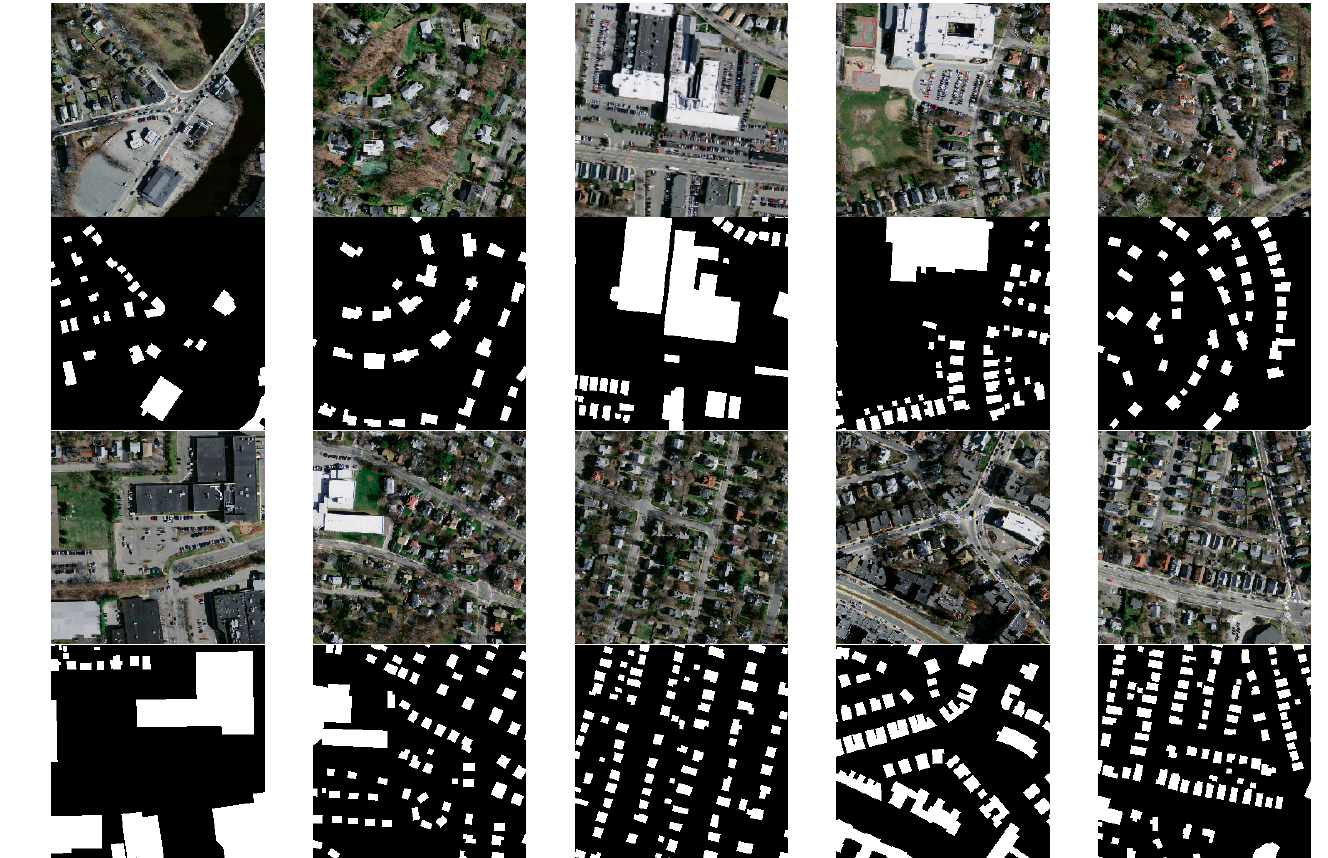
Figure 6. Samples of the Massachusetts buildings data set.